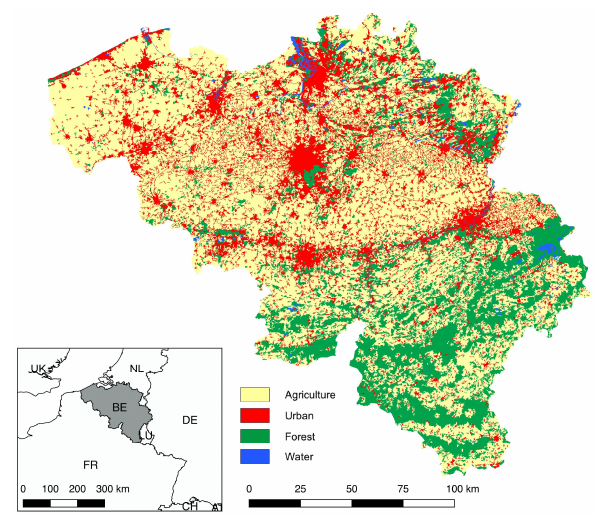
Figure 2. Land use in Belgium according to classification of Corine Land Cover data [47].